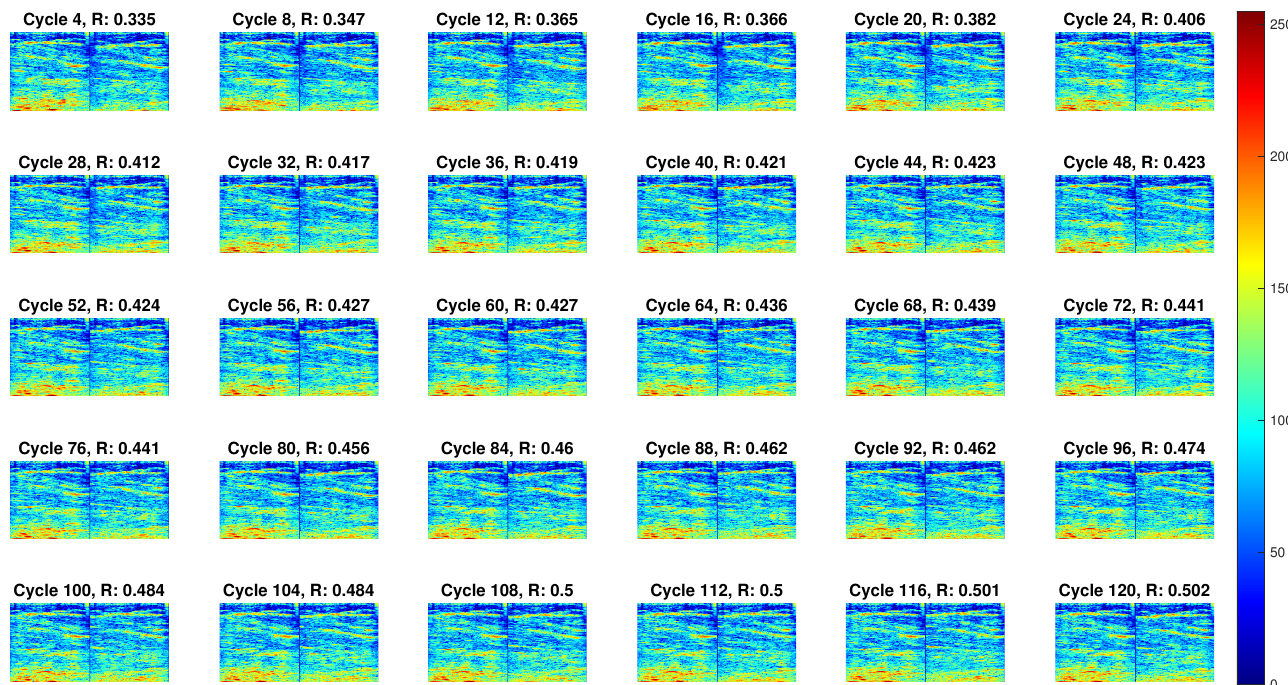
Figure 4. The first and last frames of US imaging from every 4 stimulation cycles under the dynamic fatigue progression on Participant